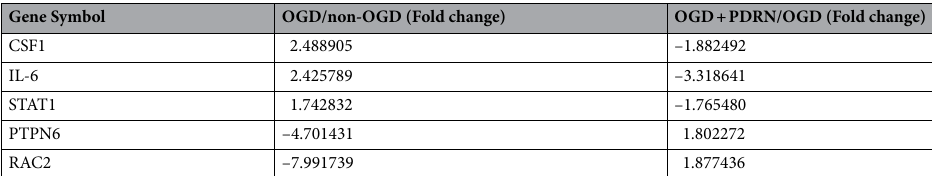
Table 1. Expression levels of inflammation-related differentially expressed genes between the OGD and non- OGD groups and the OGD and OGD + PDRN groups. CSF1, colony-stimulating factor 1; IL-6, interleukin 6; STAT1, signal transducer and activator of transcription 1; PTPN6, protein tyrosine phosphatase non-receptor type 6; RAC2, Rac family small GTPase